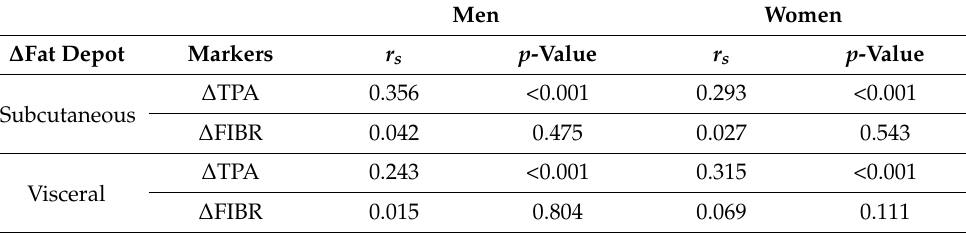
Table 3. Correlation between changes in size of different fat depots and changes in levels of TPA and FIBR. Men Women ∆ Fat